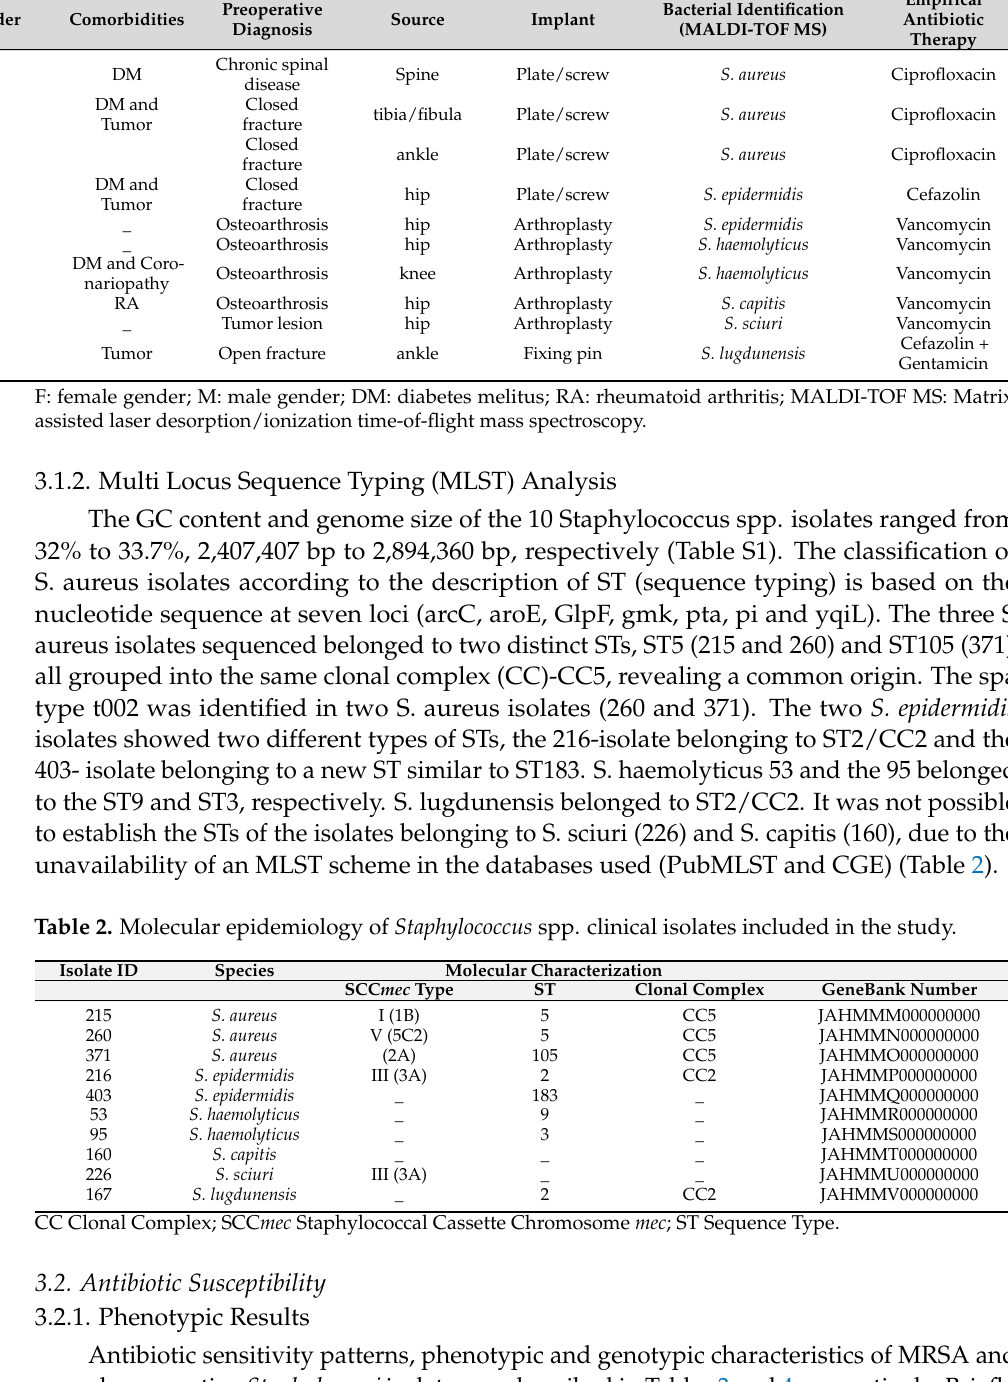
Table 1. Clinical data of patients with infections associated with orthopedic implants.